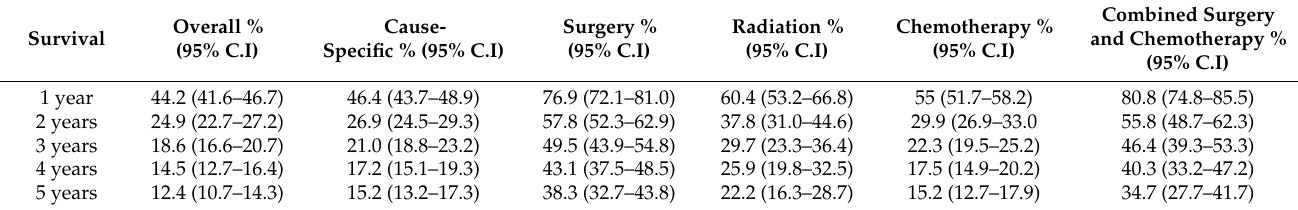
Table 5. Survival data of 2126 Patients with Combined Small-Cell Lung Cancer from the Surveillance Epidemiology and End Result (SEER) Database (2000–2018).